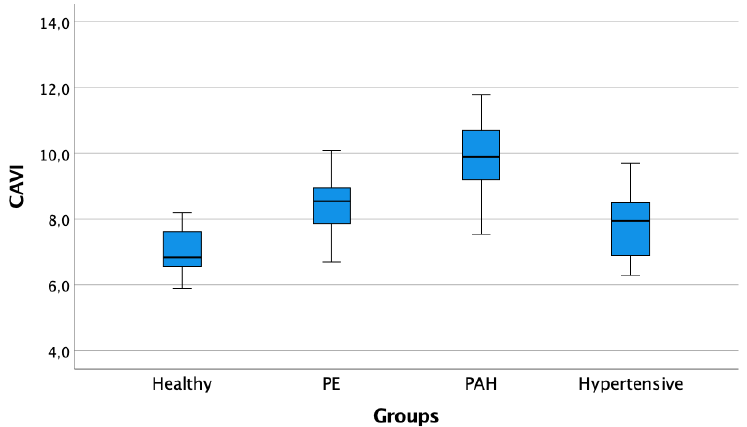
Figure 2. Boxplots of CAVI values among the different cohorts of patients. Box edges represent the 25th (Q1) and 75th (Q3) quantiles, respectively. The upper whisker is drawn at the greatest value smaller than 1.5 IQR above the third quartile, while the lower whisker is drawn at the smallest value greater than 1.5 IQR below the first quartile. Abbreviations: CAVI: cardio-ankle vascular index; PE: pulmonary embolism; PAH: pulmonary arterial